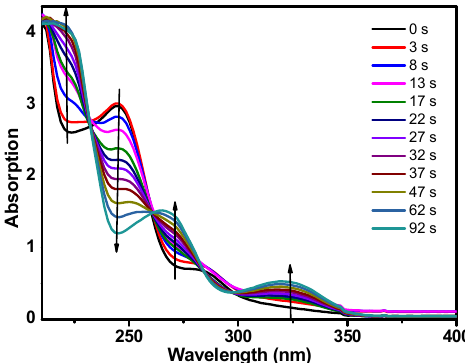
Figure 2. Steady-state absorption spectra change of DMB in MeCN (acetonitrile) with the increase of irradiation time. The wavelength of the irradiation monochromatic light is 266 nm.